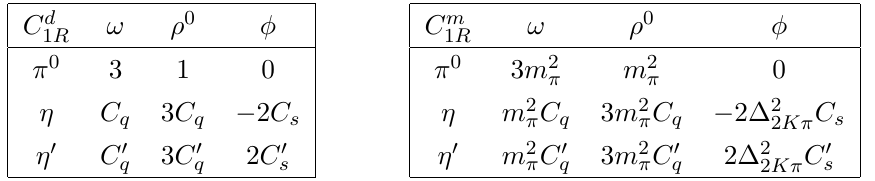
Table 5 . Values of C d